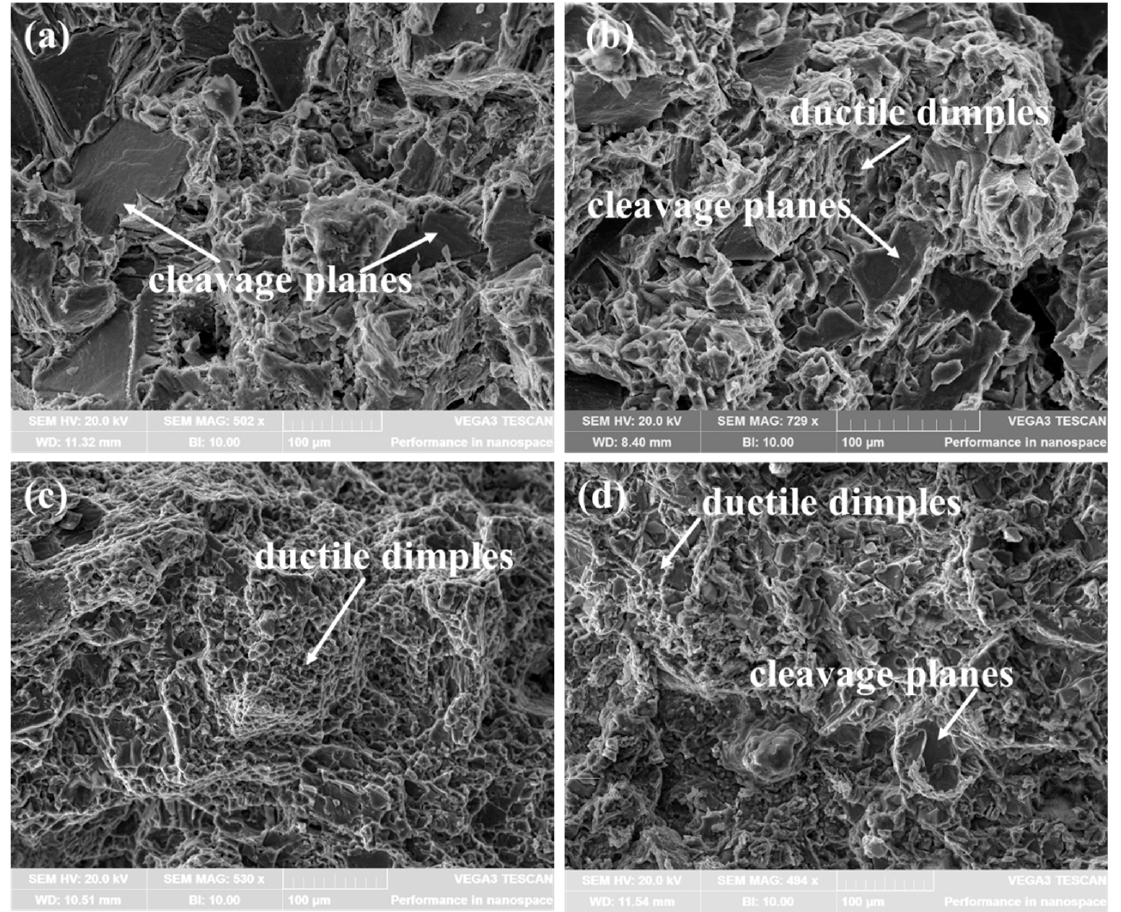
Figure 10. SEM images of fracture surfaces of the alloys and the composites: ( a ) M-AC, ( b ) 1-COM, ( c ) 3-COM, and ( d ) 5-COM.